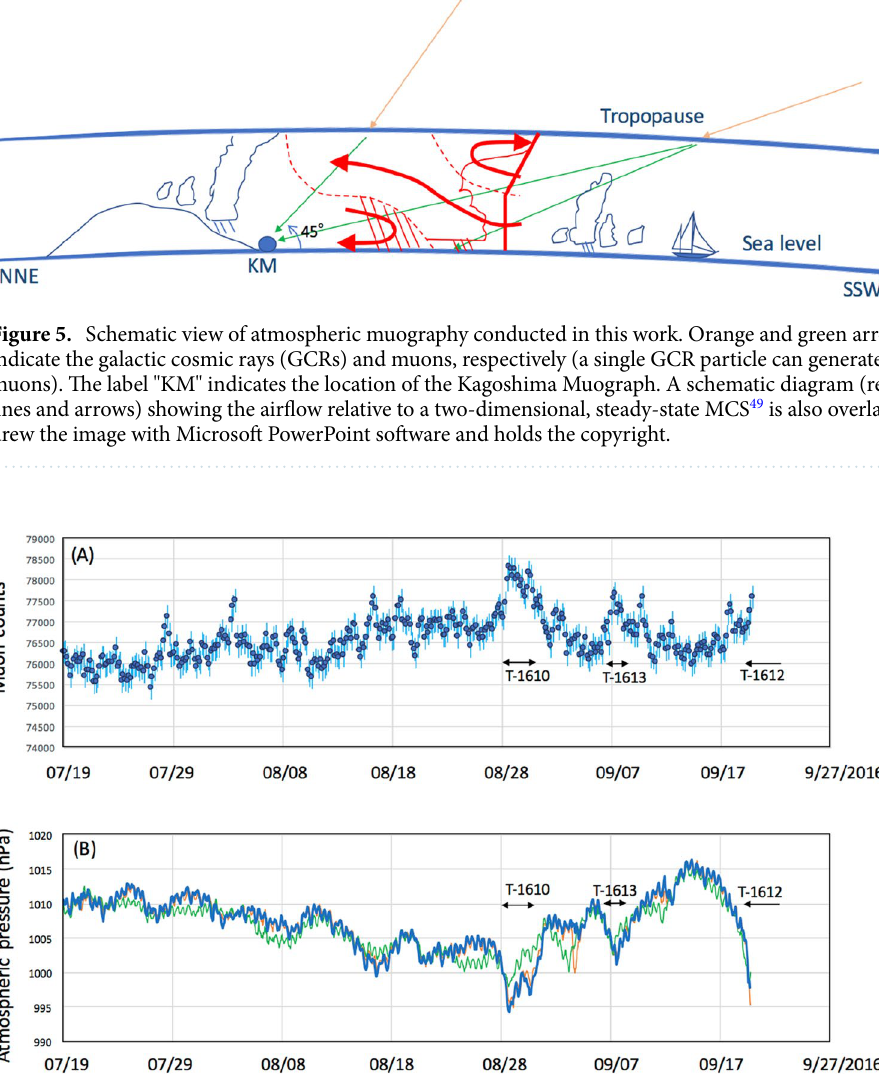
Figure 6. Observed time-dependent variations of the muon count rate in the 2016 typhoon season ( A ). The atmospheric pressure values observed at three BP monitoring stations of Kagoshima (blue), Yakushima (Orange) and Naze (Green) 48 are shown ( B ). The vertical bars associated with the data points indicate 1σ error bars. Arrows indicate the period that T1610, T1612, and T1613 are added. T1616 is out of the range of the current